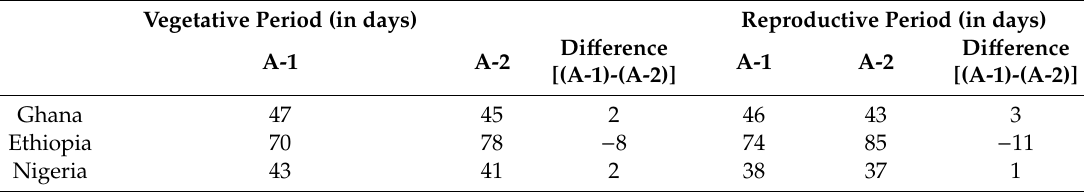
Table 6. Simulated length of the vegetative and reproductive period (in days) with Approach 1 (A-1) and Approach 2 (A-2) and the associated differences [(A-1) – (A-2)] in Ghana, Ethiopia, and Nigeria.